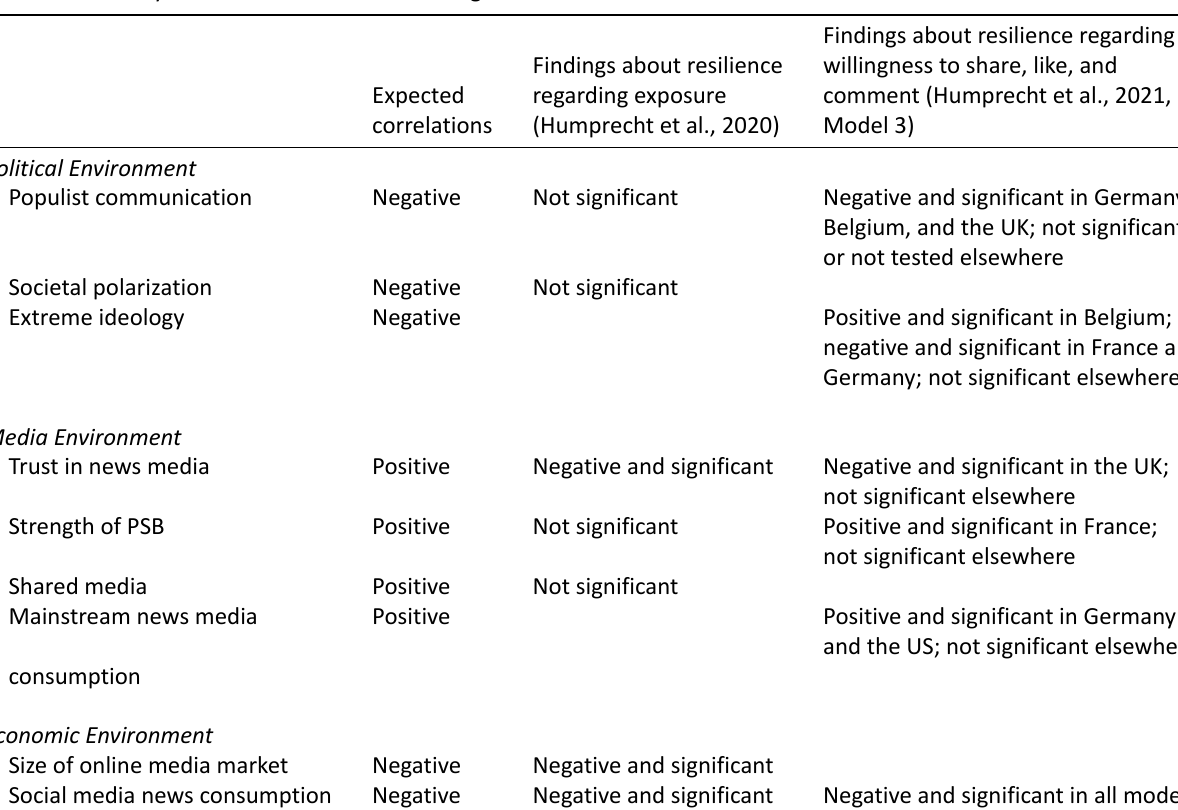
Table 1. Summary of resilience model and